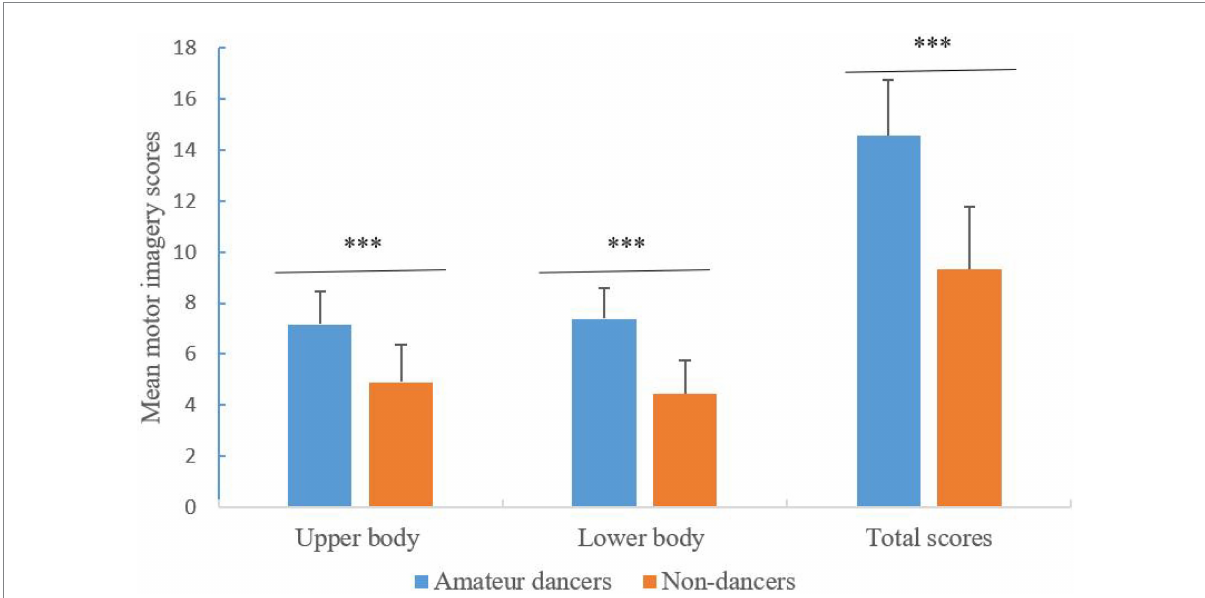
FIGURE 3 Individual differences in motor imagery between amateur dances and non-dancers assessed by the dance movement reproduction task. Asterisks indicate significance of the difference, *** p <